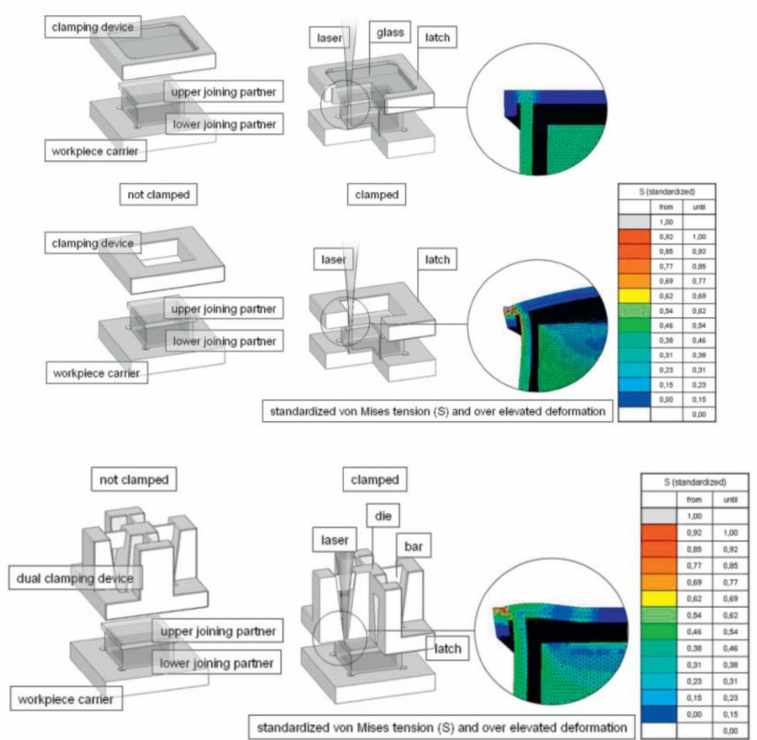
Figure 14. Schematic sketch of LTW showing: ( top ), the clamping unit placed within the beam path ( top ), clamping unit placed not within the beam path ( bottom ) and results of mechanical Finite Element Simulations showing standardised von Mises tensions and over elevated deformations caused by the different clamping techniques ( bottom ) DCD and the results of a mechanical Finite Element Simulation showcasing standardised von Mises tensions and over elevated deformations caused by the new clamping technique [189]. Reproduced with permission from Ref. [189]. Copyright (2013), Physics